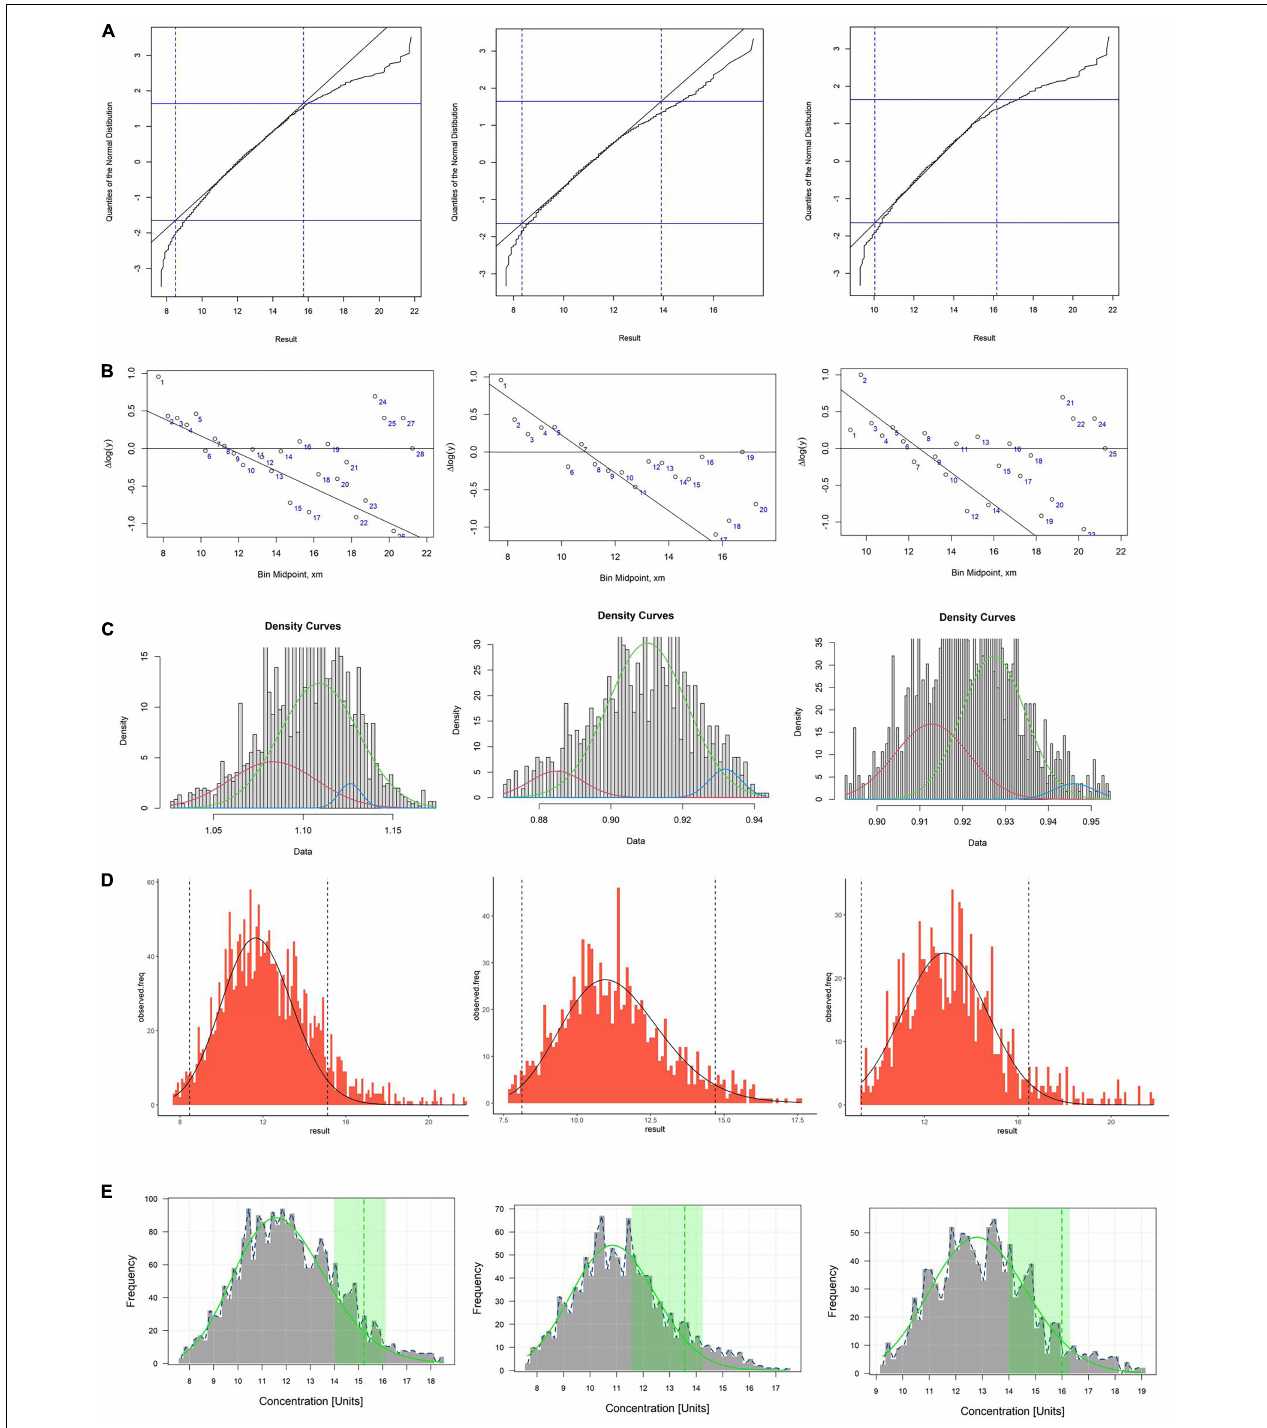
FIGURE 2 | (A–E) Respectively, stand for Hoffman, Bhattacharya, EM, kosmic and refineR algorithms. The first column represents the total reference interval, the second column represents the reference interval for females, and the third column represents the reference interval for males. (A,B) In the plot of Hoffmann and Bhattacharya, linear region represents the distribution of healthy individuals and RI were determined by extending the linear region of the healthy subgroup. (C) The green curve represents the distribution of healthy individuals and RI were determined by distribution of green curve. (D) The algorithm minimizes the difference between an estimated parametrical distribution and a truncated part (the interval between two vertical dashed lines) of the observed distribution, and RI were determined by estimated parametrical distribution (the distribution curve in the graph). (E) The green curve in plot represents the distribution of healthy individuals and the green vertical dotted line indicates the upper limit of the estimated